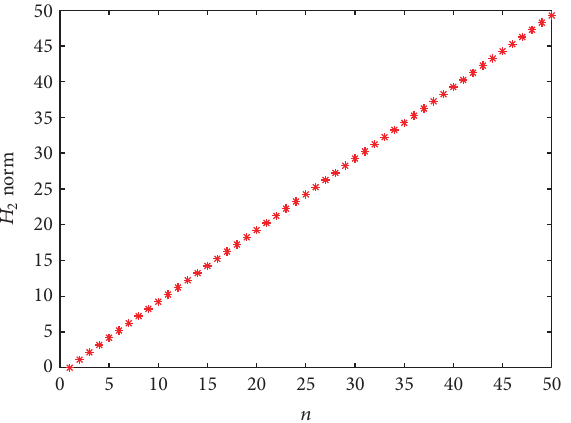
Figure 20: The variance of 𝐻 2 norm for network ( 𝑖 ) when 𝑁 = 100 , 𝑖 = 1,2, 3 .